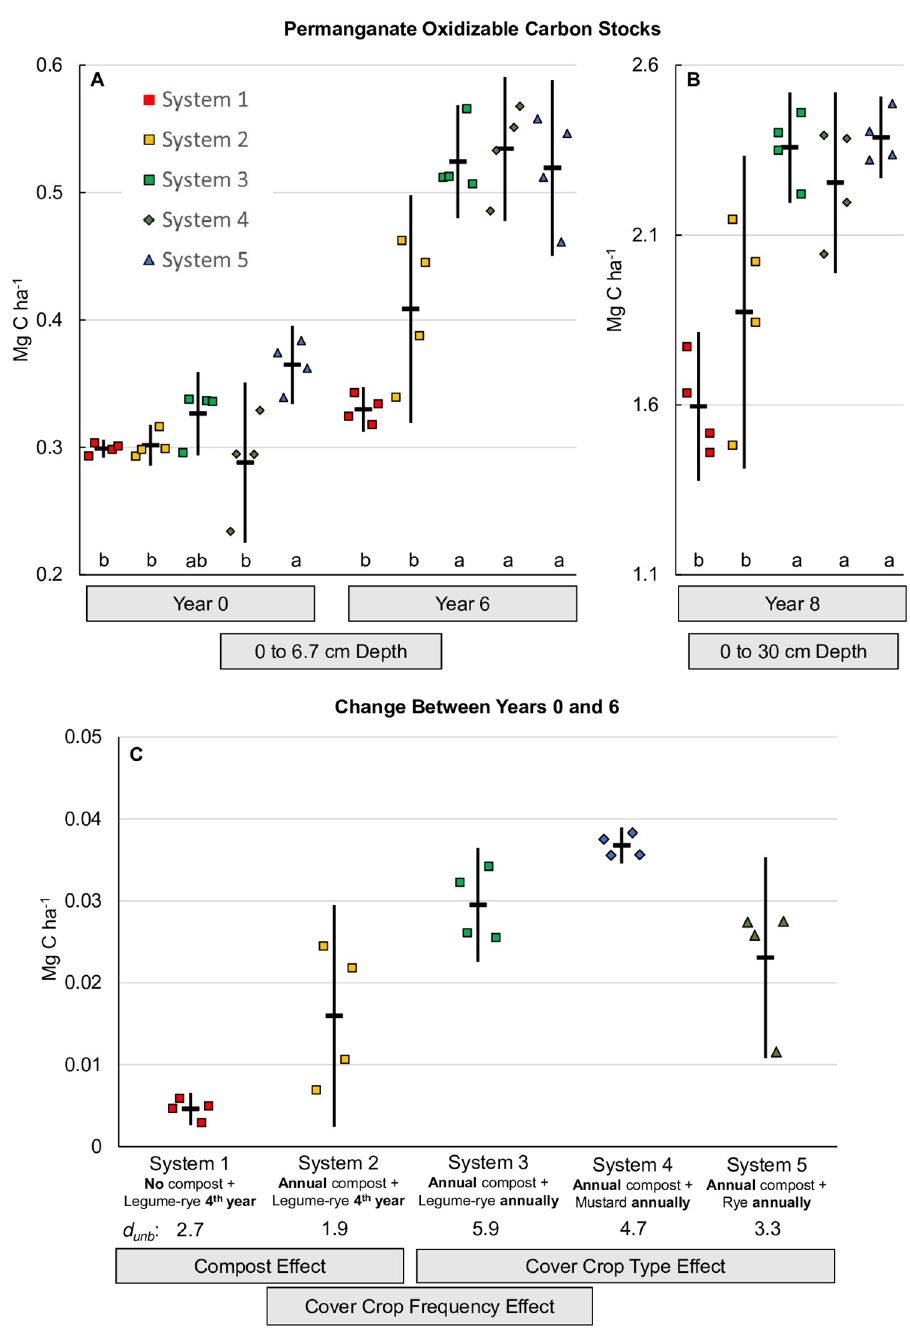
Fig 7. Mean permanganate oxidizable carbon stocks. Measurements were taken at the 0 to 6.7 cm depth for years 0 and 6 (A), the 0 to 30 cm depth in year 8 (B) and the change between year 0 and 6 at the 0 to 6.7 cm depth (C) in five organic vegetable systems in Salinas, CA. Systems differed by annual compost additions (0 vs. 7.6 Mg ha -1 before each vegetable crop), cover crop type (legume-rye, mustard, or cereal rye alone) and cover cropping frequency (quadrennially vs. annually planted). Error bars are 95% confidence limits. Individual data points for reps 1 through 4 of each system are clustered in order from left to right around the mean, which is represented by the horizontal lines. Mean permanganate oxidizable carbon stock at the 0 to 6.7 cm depth (Mg ha -1 ) was 24 (System 1), 33 (System 2), 36 (System 3), 35 (System 4) and 36 (System 5). Within a year, means with the same letter above the x-axis in plot A are not significantly different based on the Tukey-Kramer adjusted family-wise error rate of (P � 0.05). The standardized effect size (Cohen’s unbiased d , d unb ) is shown below the x-axis labels in plot